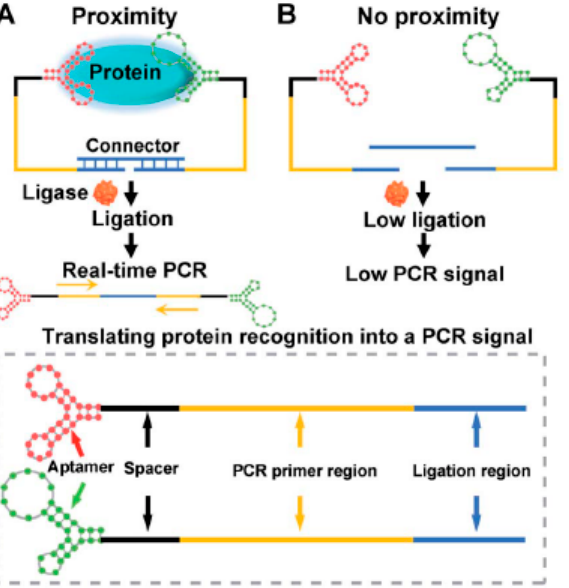
Figure 2. Schematic representation of the aptamer ‐ assisted proximity ligation assay for COVID ‐ 19 antigens. The aptamer ‐ proximity ligation assay has two important components: two proximity ligation probes: an aptamer region for target recognition and a spacer region to minimize the structural steric hindrance(obstruction). ( A )The binding of the two aptamers to the same protein target could bring the ligation region into close proximity. Then, the two ligated aptamers hybrid ‐ ize with the connector template, to form a DNA (Desoxyribonucleic acid) complex used for sub ‐ sequent ligation ‐ dependent qPCR (quantitative PCR) amplification. ( B )The absence of the target hampers the proximity of the two probes leading to a low ligation event and weak nonspecific qPCR signals. Reprinted with permission from